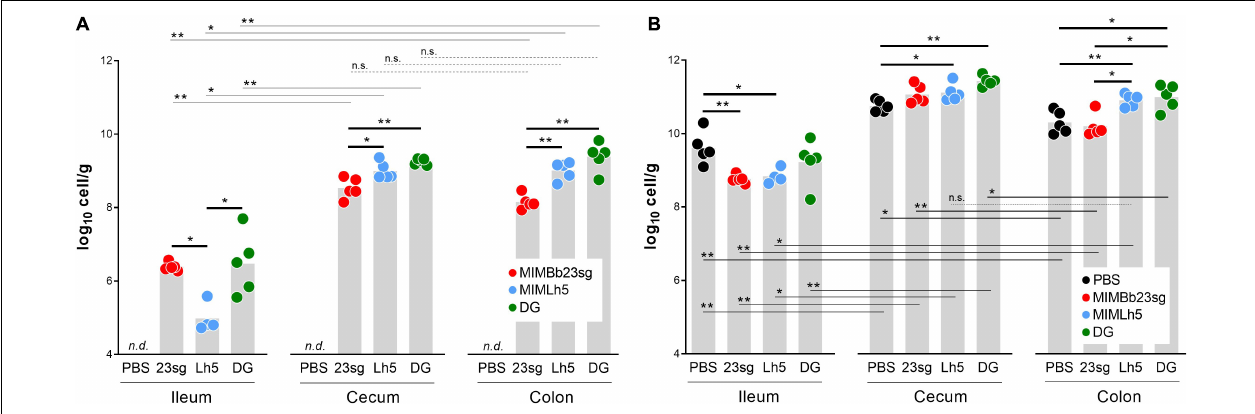
FIGURE 1 | Bacterial quantification by qPCR in mouse intestinal sites. (A) qPCR experiments performed with the respective strain-specific primers. (B) qPCR experiments performed with pan-bacterial primers. PBS, control mice gavaged with phosphate buffered saline; 23sg, mice gavaged with B. bifidum MIMBb23sg;